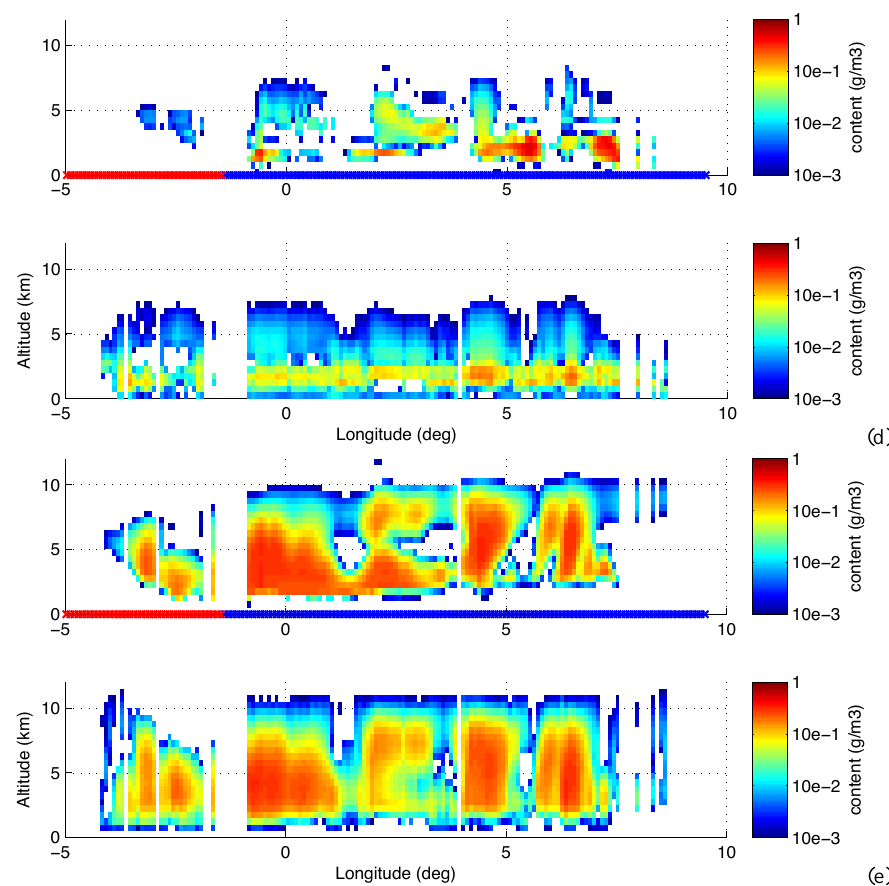
Fig. 6. Hydrometeor content profile retrieval for the MESO-NH microphysics species cloud ice, graupel, snow, rain, and cloud liquid. For each species, original (top panels) and retrieved (bottom panels) profiles are shown along a longitudinal transect for a simulated case over the Mediterranean Sea (the Algier case of the SIMGEO database, Chaboureau et al., 2008). Sea and land surface cases are indicated in blue and red in each top panel. (a) Ice, (b) rain, (c) graupel, (d) liquid and (e) snow. Table 8. Estimated RMS error (in %) of precipitation rate for 3 different ranges. The last three columns show the corresponding threshold accuracies (and breakthrough accuracies in parentheses) for different applications. Applications considered are numerical weather prediction (NWP) and hydrology, with requirements taken from the EUMETSAT Position paper (Rizzi et al., 2006). Precipitation CloudIce RMS NWP global NWP regional Hydrology rate range retrieval error